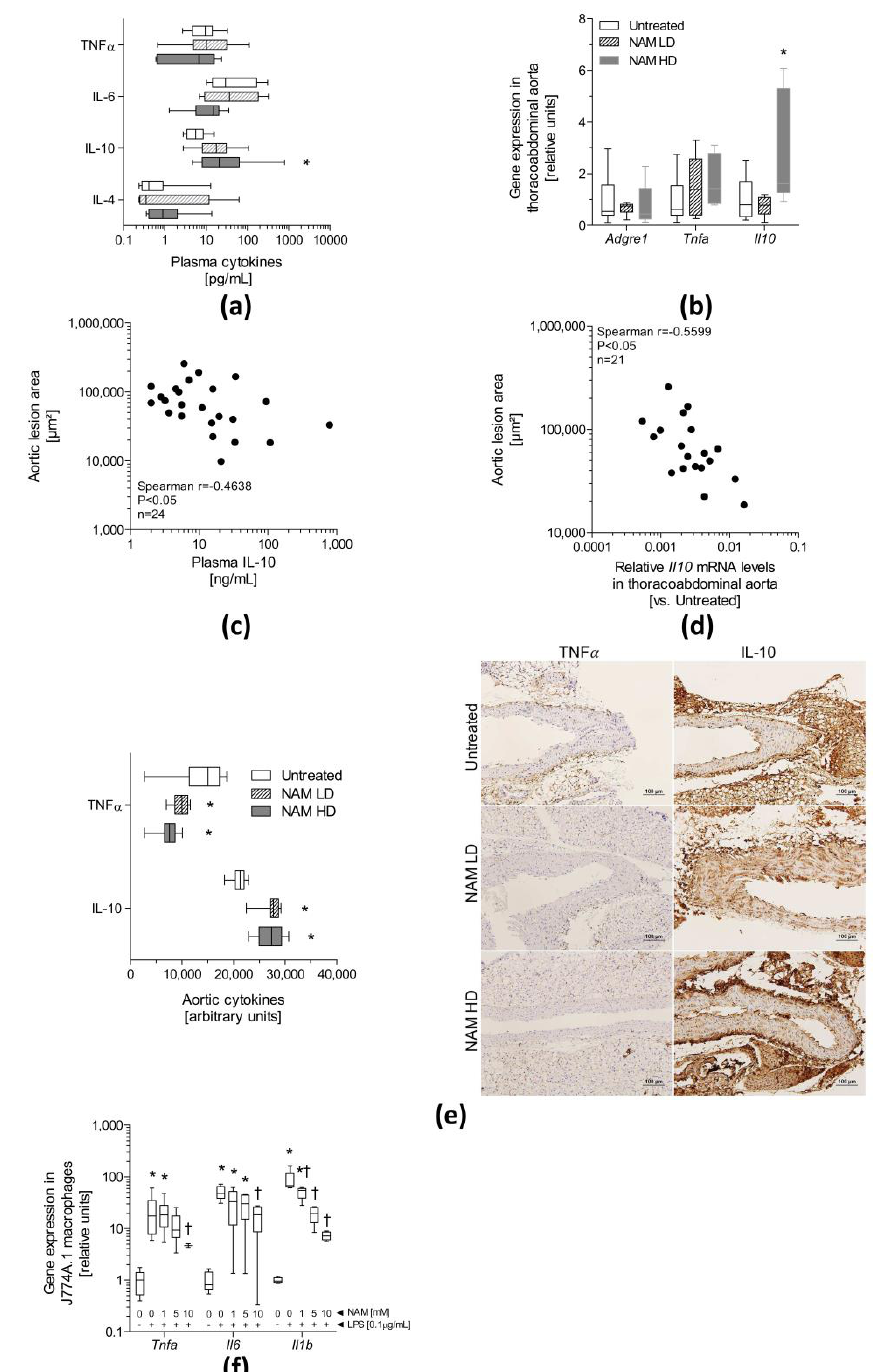
Figure 3. Anti-inflammatory e ff ects of NAM on ApoE-deficient mice and cultured macrophages. Two-month-old male ApoE-deficient mice were challenged with a Western diet and NAM for 1 month. ( a ) Plasma concentration of cytokines (TNF α , IL-6, IL-10, and IL-4) in ApoE-deficient mice ( n = 5–6). ( b ) Relative aortic mRNA levels of inflammatory targets. ( c ) Correlation between the area of proximal aortic lesions and circulating IL-10 levels. ( d ) Correlation between the area of proximal aortic lesions and Il10 aortic mRNA levels. ( e ) Immunohistochemical (IHC) analysis of TNF α and IL-10 levels in the aorta. Left panel, bar chart showing the relative (arbitrary units) expression of TNF α and IL-10 in the aortas from di ff erent groups ( n = 5–6 mice per group). Right panel, representative images of immunohistochemical staining for IL-10 and TNF α in thoracoabdominal aortas. ( f ) Relative mRNA levels of cytokines assessed in LPS-activated J774A.1 macrophages exposed to di ff erent doses of